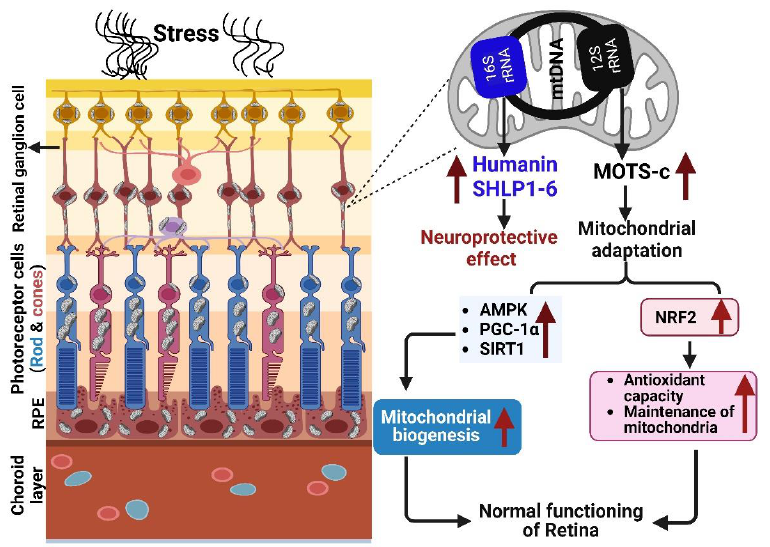
Figure 2. The mechanism of mitochondrially derived peptides, including MOTS-c, humanin, and SHLP1-6, in the retina. Red arrow indicates upregulation/increased expression. Created with Biorender.com